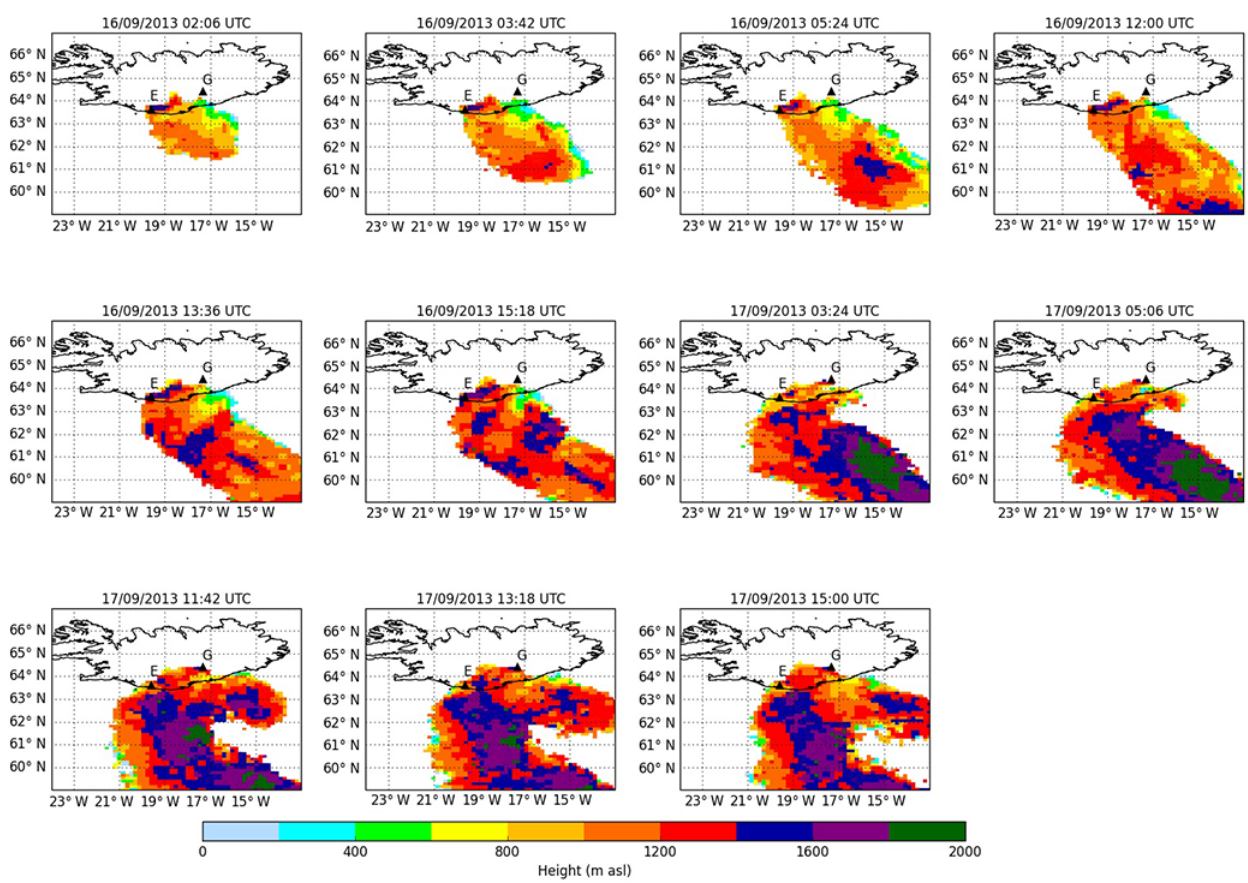
Figure 7. The maximum height of the modelled ash cloud using NAME at the times corresponding to the satellite retrievals. The locations of the volcanoes Eyjafjallajökull and Grímsvötn are indicated on the map by the E and G symbols respectively.